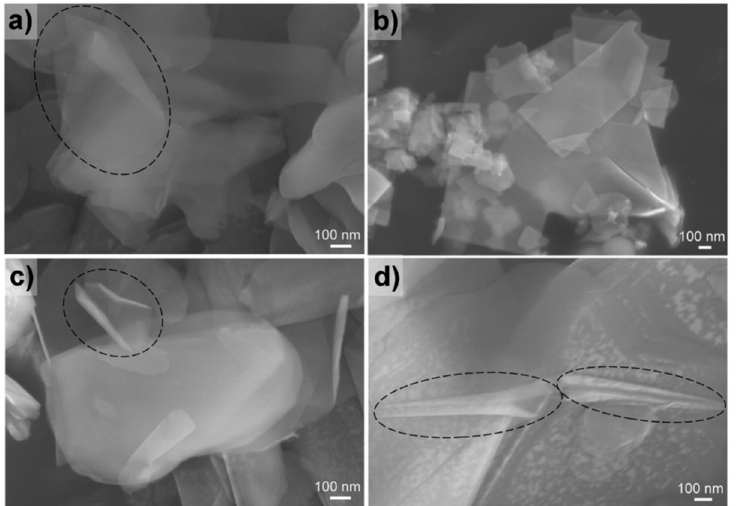
Figure 3. SEM images of hBN NSHs. ( a ) Agglomerated NSHs with several hundred nanometers in size (circled in black). ( b ) A very flat NSH. ( c,d ) Typical nanoscrolls (circled in black). Reprinted with permission from Ref. [51]. Copyright 2013, John Wiley and Sons.